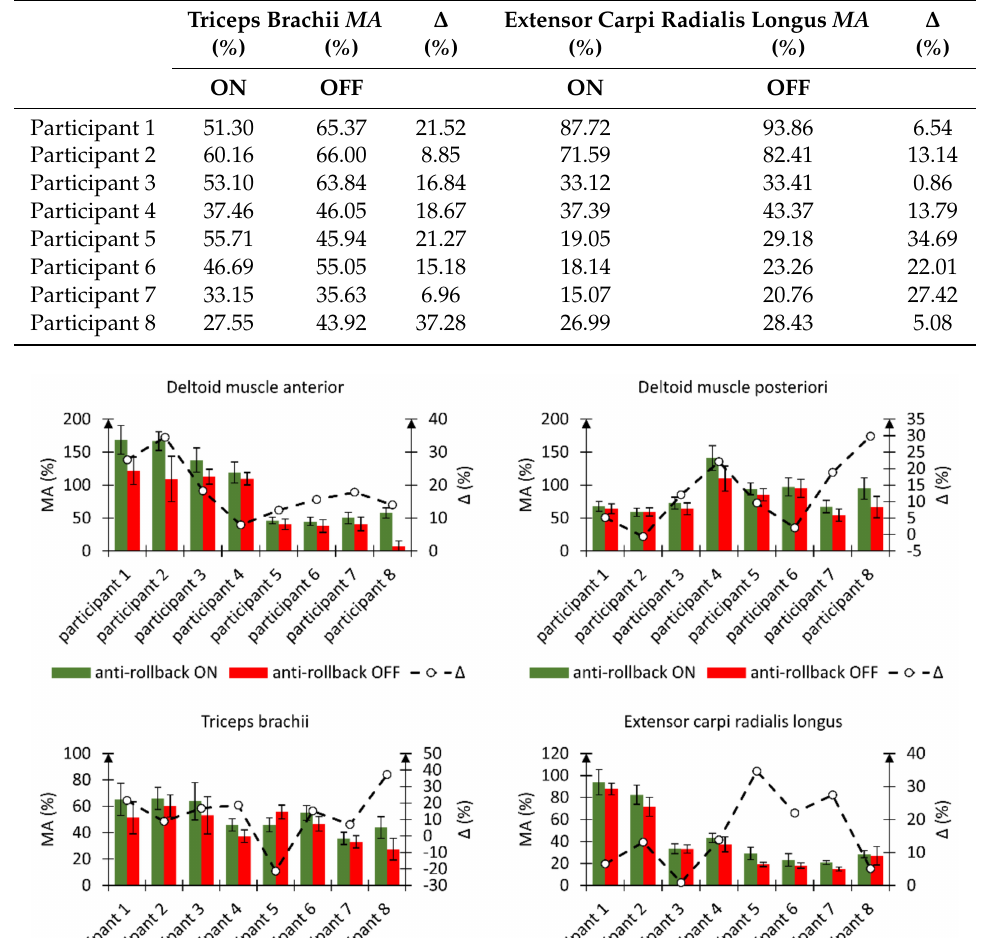
Table 7. The comparison of the average muscle activity of triceps brachii and extensor carpi radialis longus for respective participants, where MA —muscle activity, ON—activated anti-rollback system, OFF—deactivated anti-rollback system, ∆ —a percentage di ff erence between muscle activity measured with the activated anti-rollback system and the deactivated anti-rollback system.